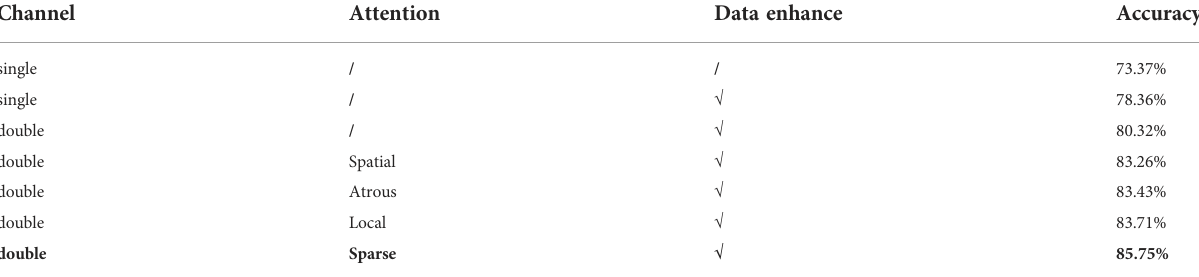
TABLE 7 Ablation Experiment.